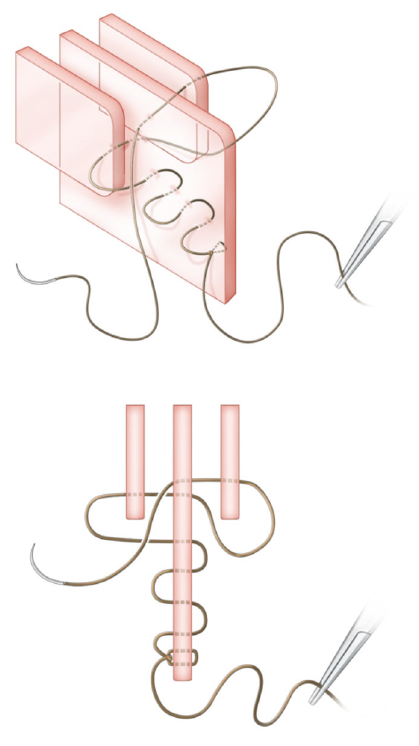
Figure 4: Oblique and axial views. Step 4. The needle is reversed and passed through the left MT and septum alone. The needle tip is then grasped on the right side between the septum and right MT and pulled tight (for demonstration purposes, the suture has been drawn loose in this figure and in Figure